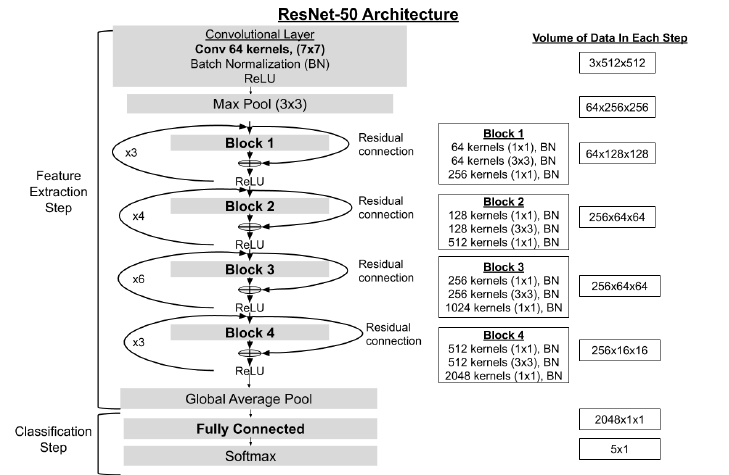
Figure A1. ResNet architecture (adapted from Table 1 and Figure 3 of [59]). The modules with learnable parameters are